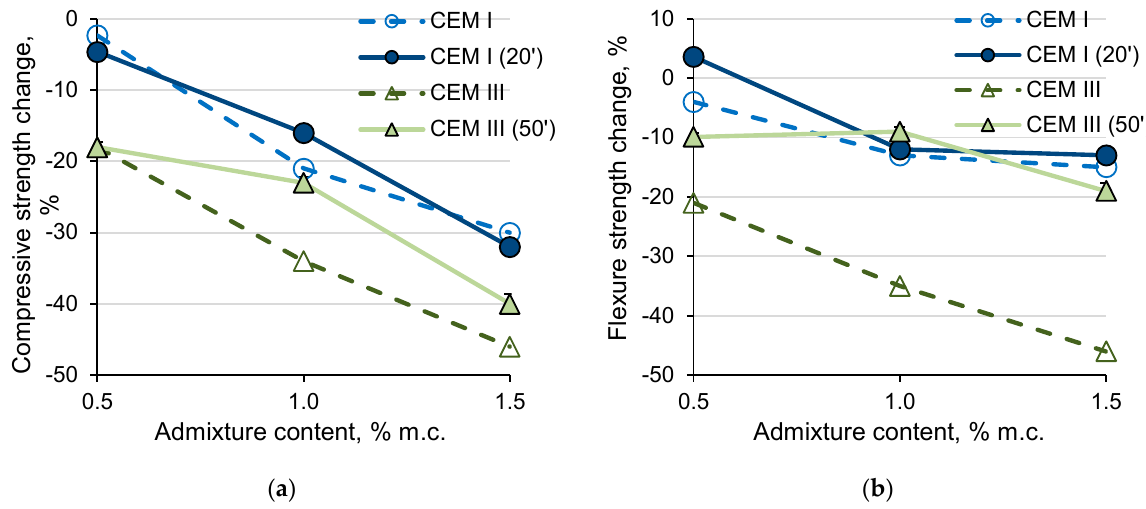
Figure 8. Compressive ( a ) and flexural ( b ) strength change of mortar with the admixture in relation to the mortar without admixture formed after mixing components of mortar (CEM I and CEM III) and formed after air content test (CEM I (20 (cid:48) ) and CEM III (50 (cid:48)